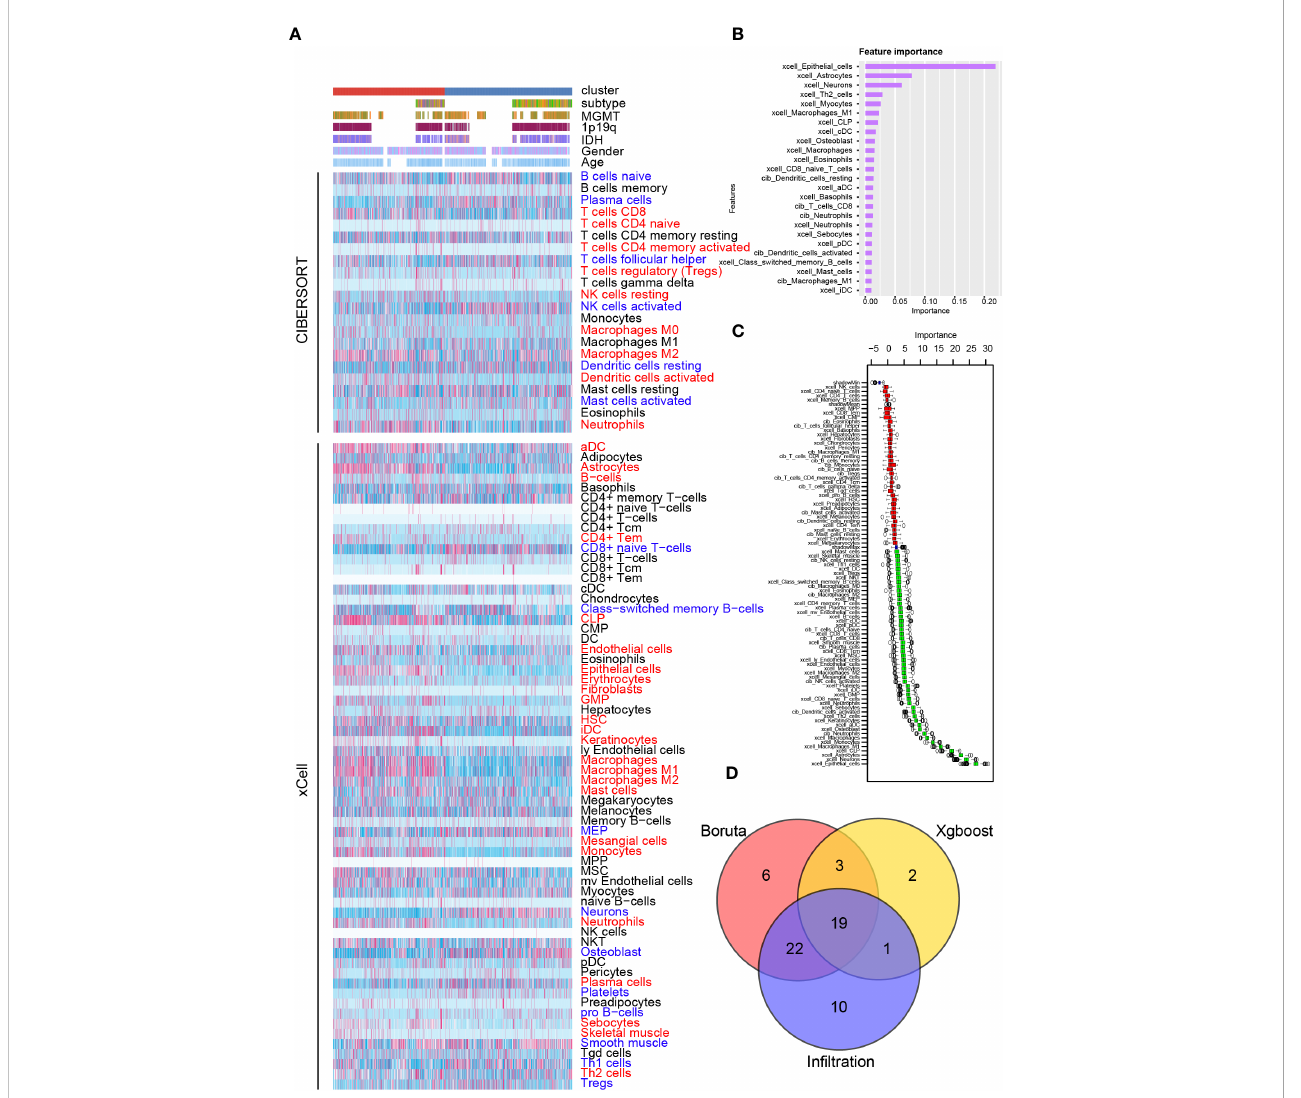
FIGURE 6 Immunocyte in fi ltration difference between cluster 1 and cluster 2. (A) Immunocyte in fi ltration analysis based on CIBERSORT and xCell algorithm. Immunocyte characteristic difference based on the cluster model using machine algorithm “ Xgboost ” (B) and “ Boruta ” (C) . (D) Interaction of immunocyte in fi ltration and results from “ Xgboost ” and “ Boruta ”